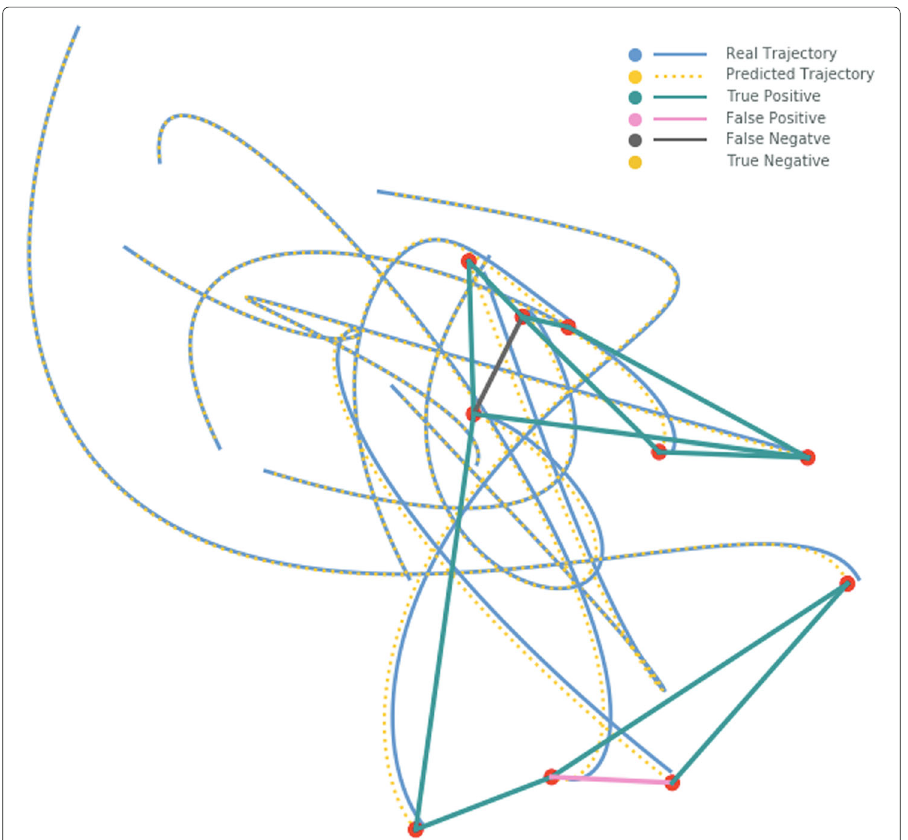
Fig. 3 Results of network reconstruction and path prediction in a 10-body spring mass system. The ground-truth and predicted trajectories are plotted by solid and dash lines. Network reconstruction results are shown in the form of bold solid lines with different